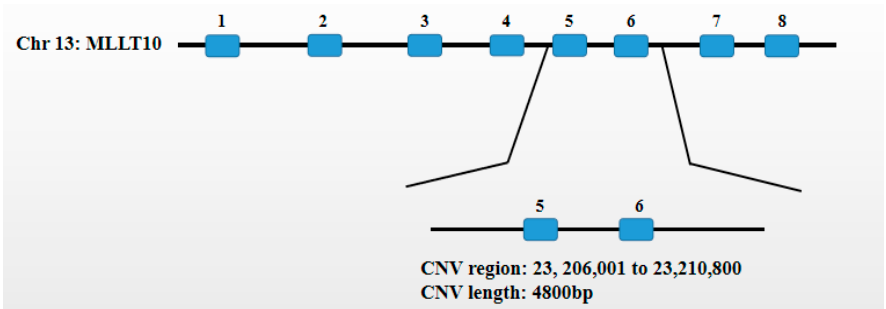
Figure 1. The region of the MTTL10 gene copy number variation (CNV) in bovine genome. The copy number variation region of the MLLT10 gene is located at Chr13:23, 206,001 to 23,210,800 bp of the MLLT10 gene, a total of 4800 bp.